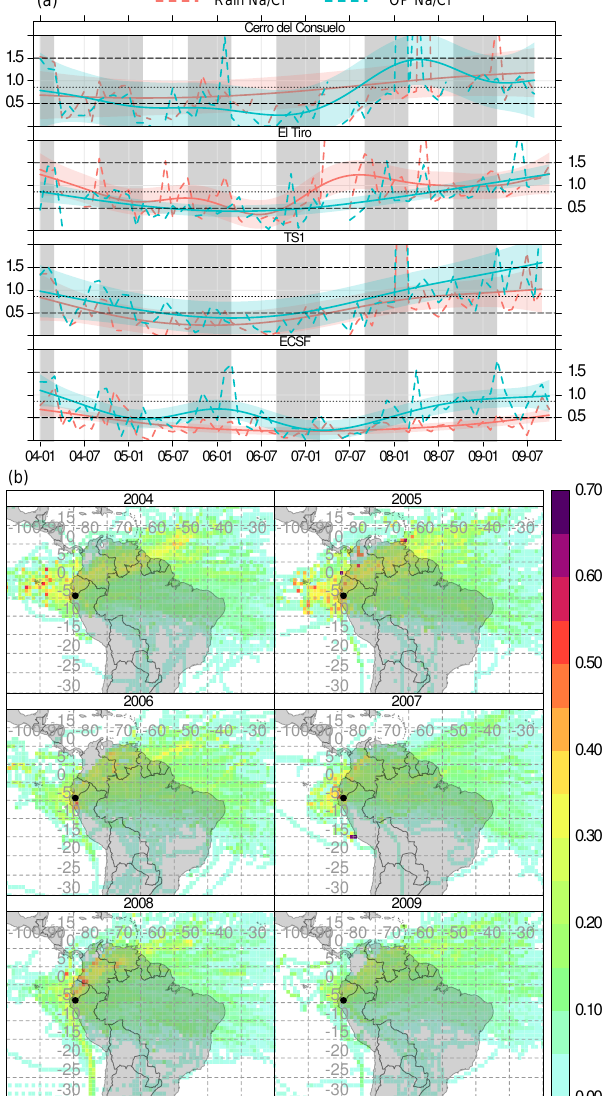
Figure 3. (a) Time series of monthly Na + / Cl − molar ratios for the four MSs along the altitudinal gradient. Smooth lines are fitted as solid lines and the 95% confidence interval is shown by the shaded area. (b) Yearly CWT sea salt source maps for southern Ecuador.